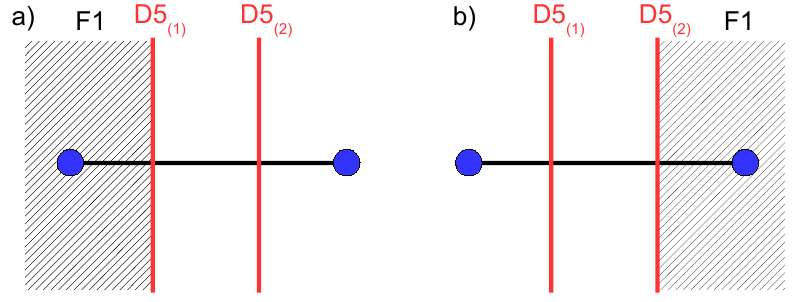
Figure 5 . Brane con(cid:12)gurations for the insertion of the meson operators (a) Z 2 1 and (b) (cid:0) Z 1 2 .